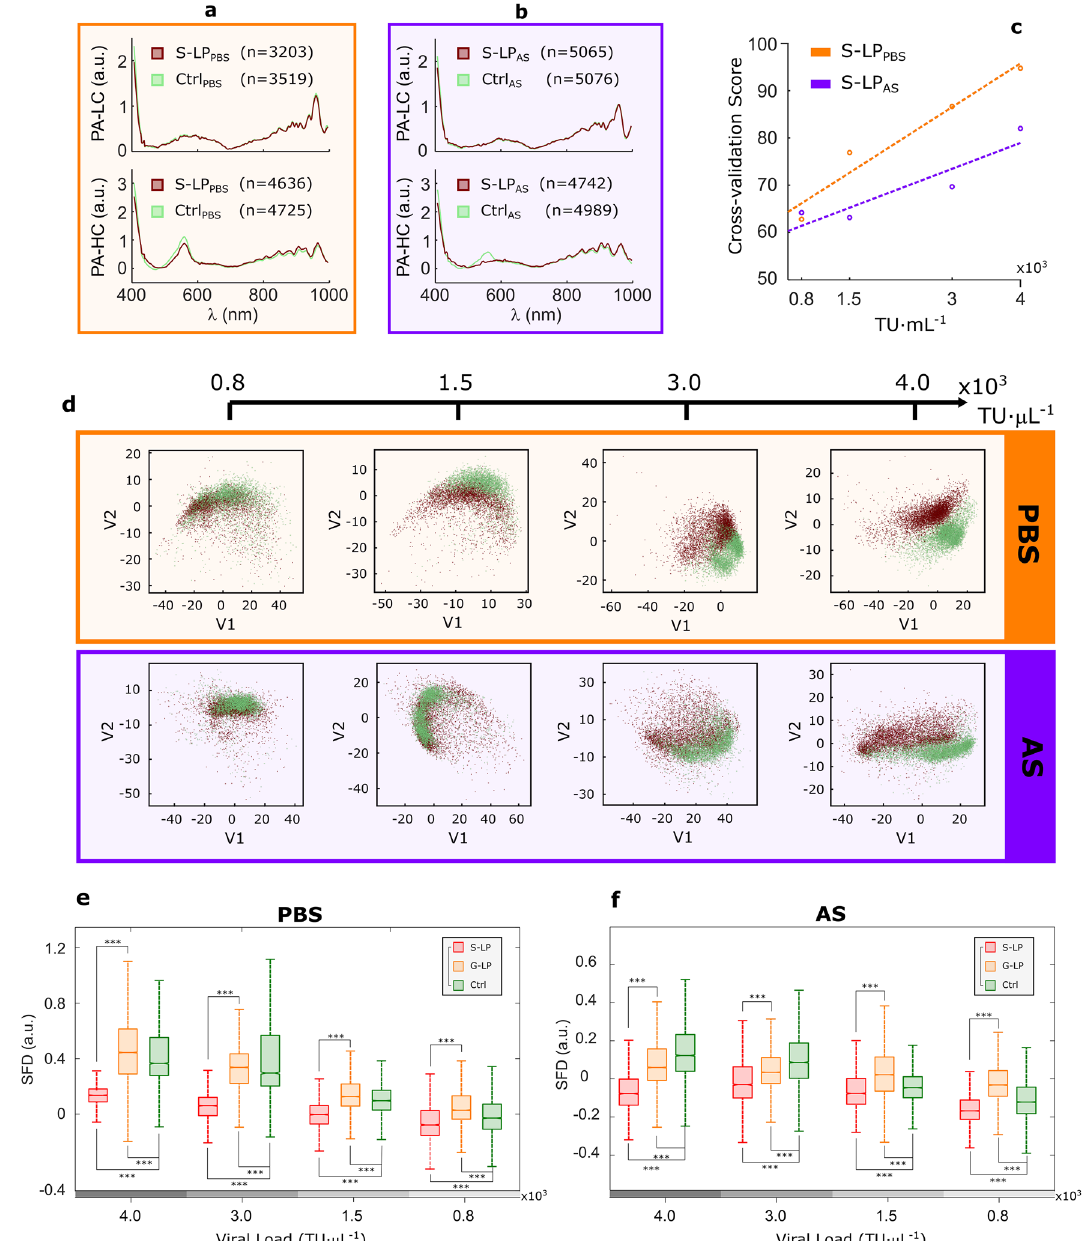
Figure 2. Experiment 1: Spectral discrimination of SARS-CoV-2 spike pseudotyped lentiviral particles. ( a ) Mean pseudo-absorbance (PA) pixel spectra of spike pseudotyped lentiviral particles in phosphate buffered solution (S-LP PBS ) for high concentration (HC = 4.0 × 10 3 TU µL −1 ) and low concentration (LC = 0.8 × 10 3 TU µL −1 ) and their respective negative controls (Ctrl PBS ). ( b ) Mean pseudo-absorbance (PA) pixel spectra of spike pseudotyped lentiviral particles in artificial saliva (S-LP AS ) for high concentration (HC = 4.0 × 10 3 TU µL −1 ) and low concentration (LC = 0.8 × 10 3 TU µL −1 ) and their respective negative controls (Ctrl AS ). ( c ) Overall score value of the tenfold cross-validation essay performed in partial least square-discriminant analysis (PLS-DA Model 1) in both preparations (per pixel). Dashed lines represent their linear correlations. ( d ) Scatter plot of the two latent variables (V1 and V2) used in the PLS-DA Model 1 for different viral concentrations. Brown and green dots represent positive and control samples respectively. ( e,f ) Spectral feature descriptor (SFD), computed in the band 483–610 nm for S-LP and G-LP samples in phosphate buffered solution (PBS), artificial saliva (AS), and the corresponding culture media as control (Ctrl). ***p-value = 0 using the Wilcoxon rank sum test. Outliers were removed for